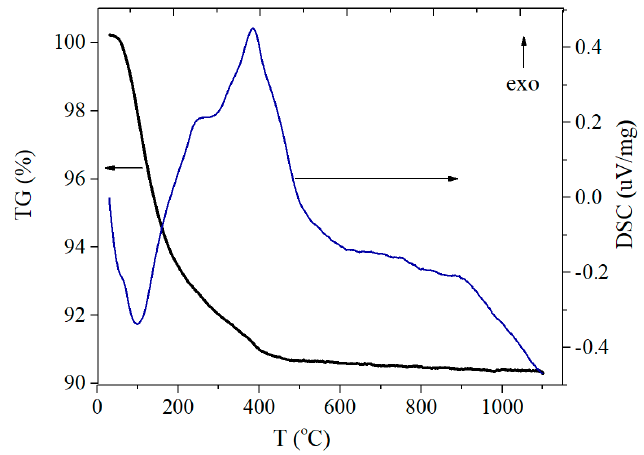
Figure 3. Thermogravimetry/differential scanning calorimetry (TG/DSC) curves of TiO 2 _ini.